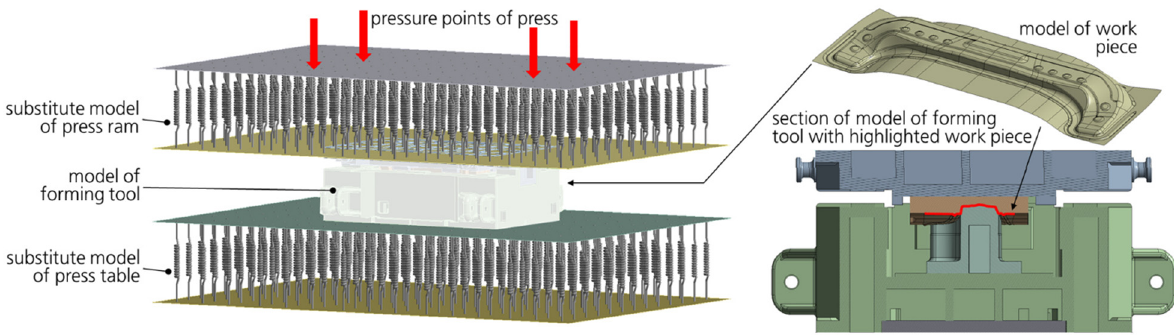
Figure 9. FE model for calculation of virtual spotting pattern, including formed workpiece.